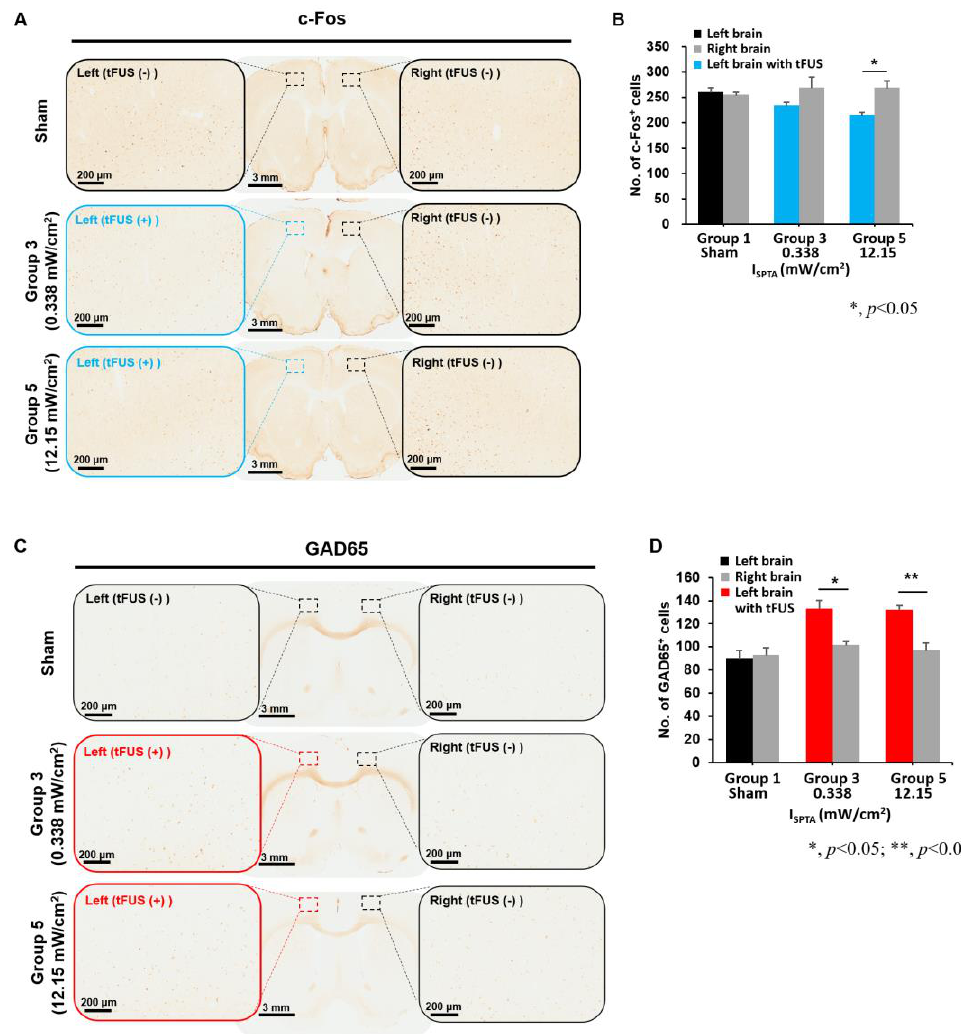
Figure 5. Comparison of c-Fos and GAD-65 signals in motor cortexes among the tested groups, including groups 1 (sham), 3, and 5. ( A ) A typical example of c-Fos staining ( B ) c-Fos-positive cell change in group 1 (sham), group 3 (I SPTA = 0.338 mW/cm 2 ), and group 5 (I SPTA = 12.15 mW/cm 2 ). Blue windows and bars represent the effects of tFUS. ( C ) A typical example of GAD-65 staining ( D ) GAD-65-positive cell changes in group 1 (sham), group 3 (I SPTA = 0.338 mW/cm 2 ), and group 5 (I SPTA = 12.15 mW/cm 2 ). Red windows and blue bars represent the effects of tFUS. (* and ** represent p values of <0.05 and <0.01,